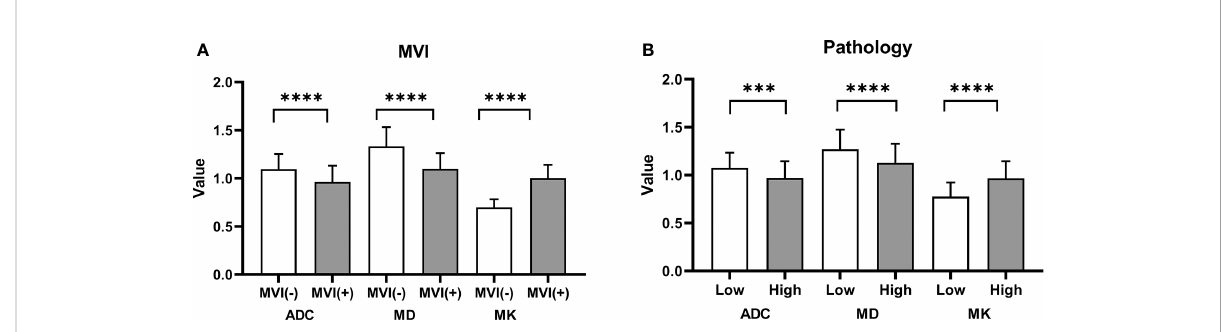
FIGURE 3 Histogram of the ADC, MK, and MD values classi fi ed by MVI and pathology grade. (A) Signi fi cant differences were observed in the ADC, MK, and MD values between groups with MVI and without MVI. (B) The differences in the ADC, MK, and MD values between a high grade and a low